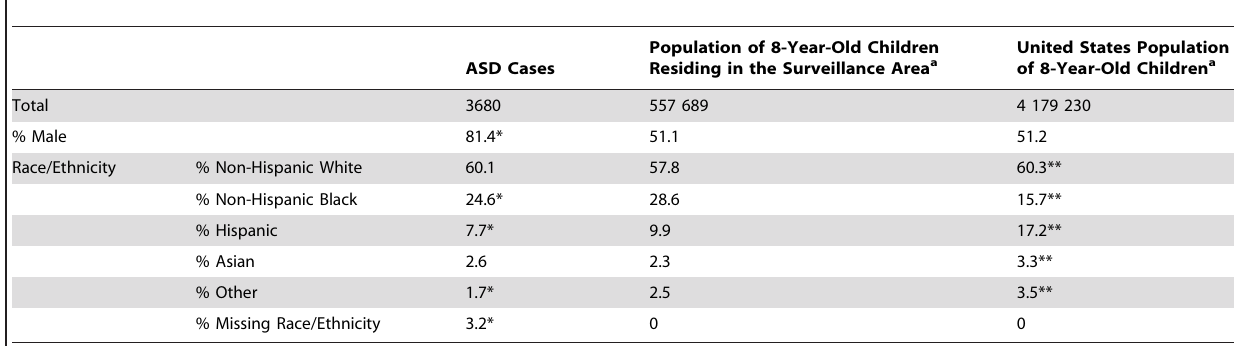
Table 1. Demographic Characteristics of ASD Cases, Population of 8-Year-Old Children in the Surveillance Area and Overall United States Population of 8-Year-Old